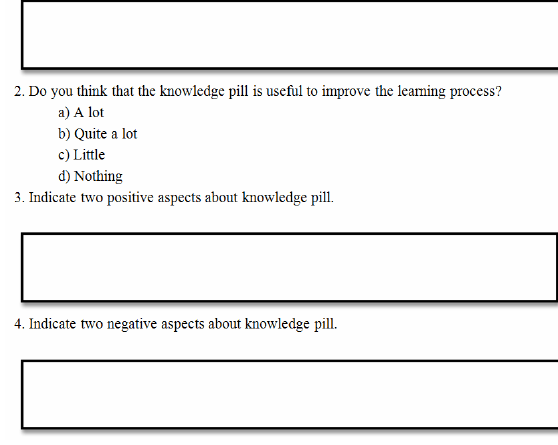
Figure 4. Questionnaire.